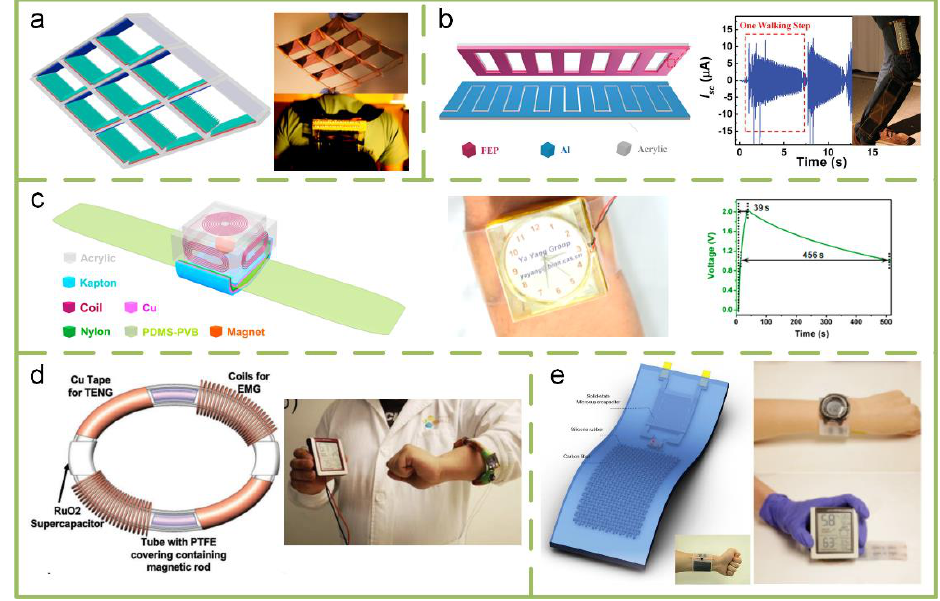
Figure 9. Self-powered sensors based on wearable TENGs. ( a ) A TENG with integrated